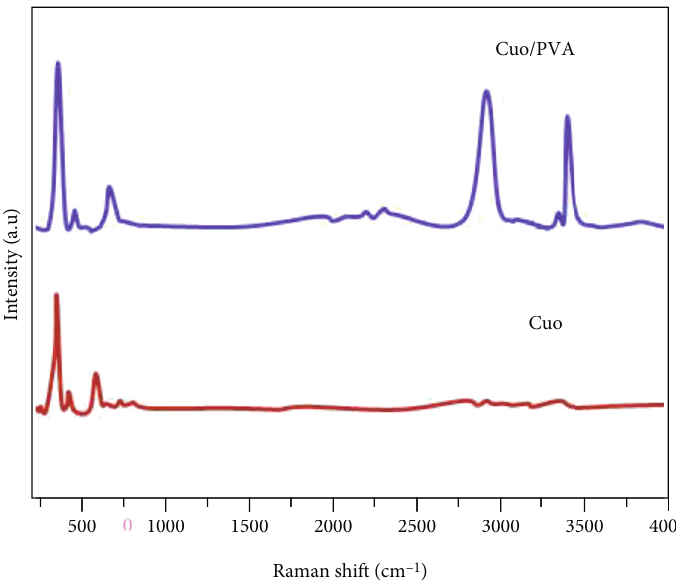
Figure 2: Raman spectrum of (a) CuO and (b) CuO/PVA nanocomposites.